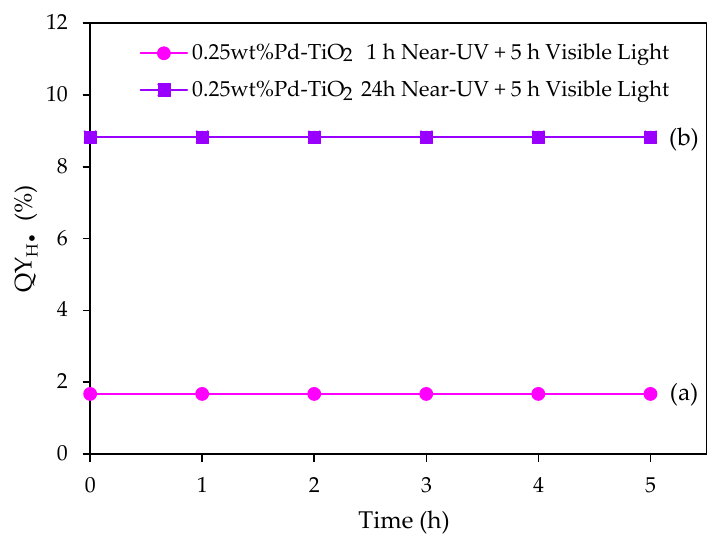
Figure 15. QY H • % at various visible light irradiation times: (a) 1 h of near-UV photoreduction, followed by 5 h of visible light irradiation; and (b) 24 h of near-UV photoreduction, followed by 5 h of visible light irradiation. Note: Conditions: 0.15 g L − 1 concentration of 0.25 wt% Pd on TiO 2 ; 2.0 v / v % ethanol; initial pH = 4 ±